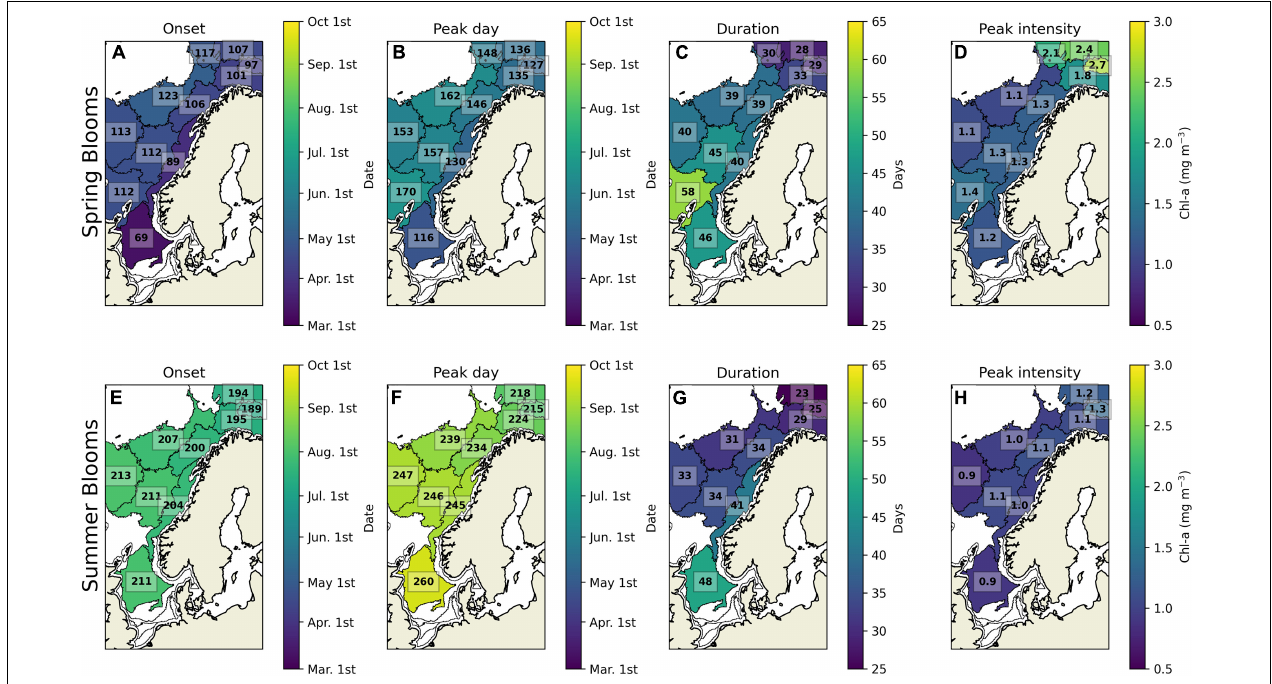
FIGURE 4 | Climatology of spring and summer blooms phenology. The subplots are the spring bloom (A) onset, (B) peak day, (C) duration, and (D) intensity; the summer blooms (E) onset, (F) peak day, (G) duration, and (H) intensity. The numbers in the onset and peak day are Julian days; in the duration are in days; in the peak intensity are in Chl-a (mg m − 3 ). Sub-regions where quantity is untrustworthy are masked in white.